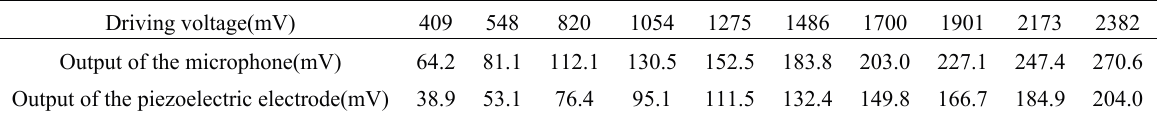
Table 2. Testing results of the piezoelectric electrode and the microphone.